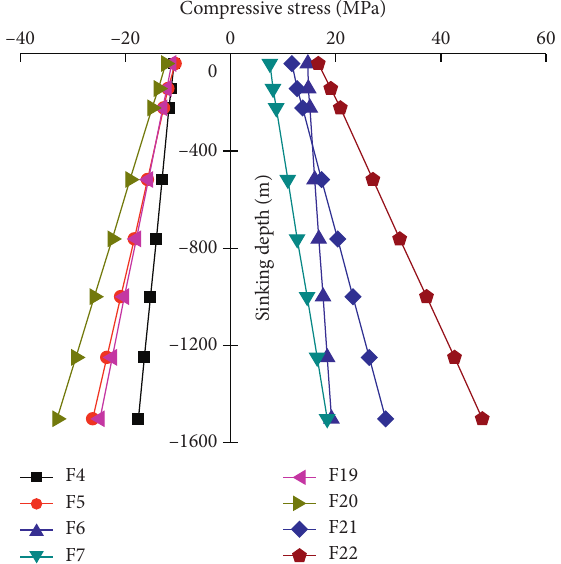
Figure 7: The theoretical stress curve of middle supporting bars under different working conditions.